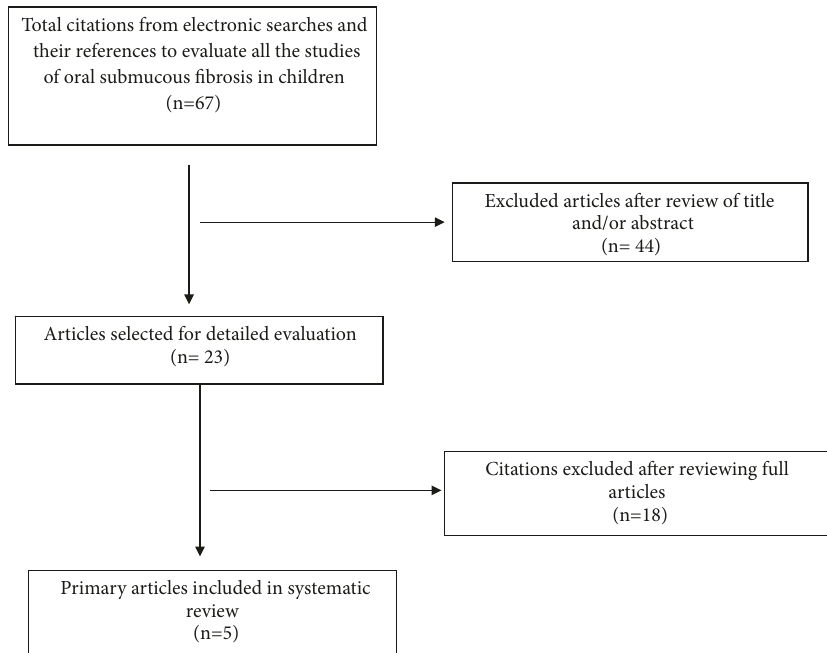
Figure 1: Flow diagram of study selection